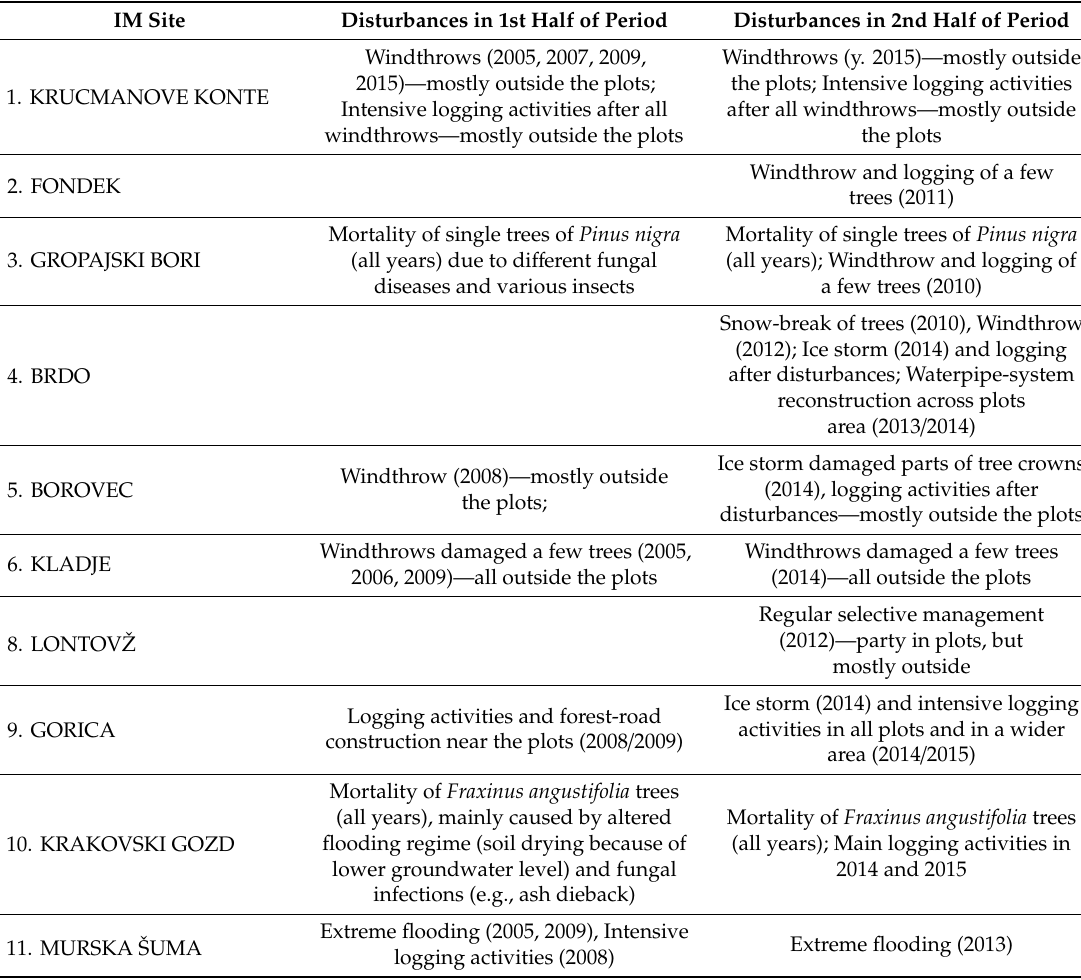
Table 2. Major disturbance events in the Intensive Monitoring sites between 2004 and